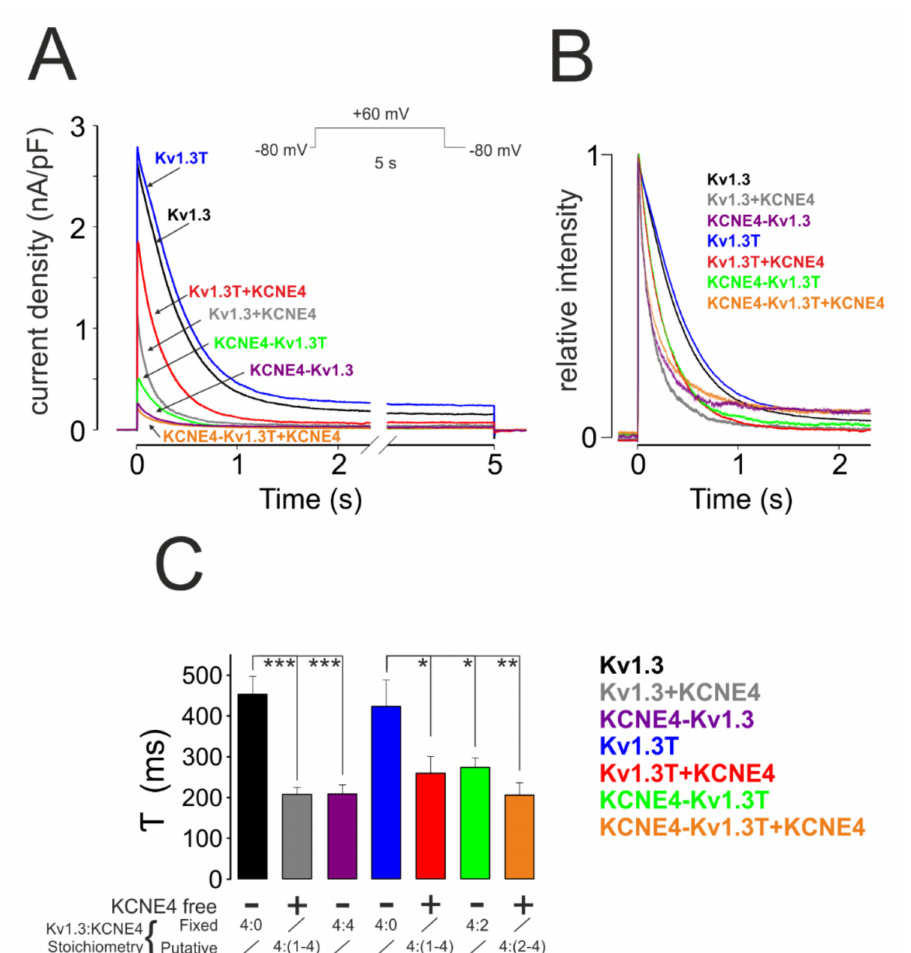
Figure 5. Analysis of C-type inactivation. HEK-293 cells were transfected with di ff erent Kv1.3-KCNE4 chimeras with ( + ) or without ( − ) free KCNE4. Di ff erent combinations yielded fixed and putative Kv1.3:KCNE4 stoichiometries. ( A ) Representative traces from C-type inactivation recordings. An initial 100 ms pulse at − 80 mV was applied prior to a 5 s depolarizing pulse at + 60 mV. ( B ) Relative intensity of voltage-dependent K + currents from all combinations during the first 2 s. ( C ) The constant ( τ ) of inactivation (in ms) of all groups. Values are the means ± SE, n = 8–14; * p < 0.05, ** p < 0.01, and *** p < 0.001 (Student’s t -test). Kv1.3 (black); Kv1.3 + KCNE4 (gray); KCNE4-Kv1.3 (purple); Kv1.3T (blue); Kv1.3T + KCNE4 (red); KCNE4-Kv1.3T (green); and KCNE4-Kv1.3T + KCNE4